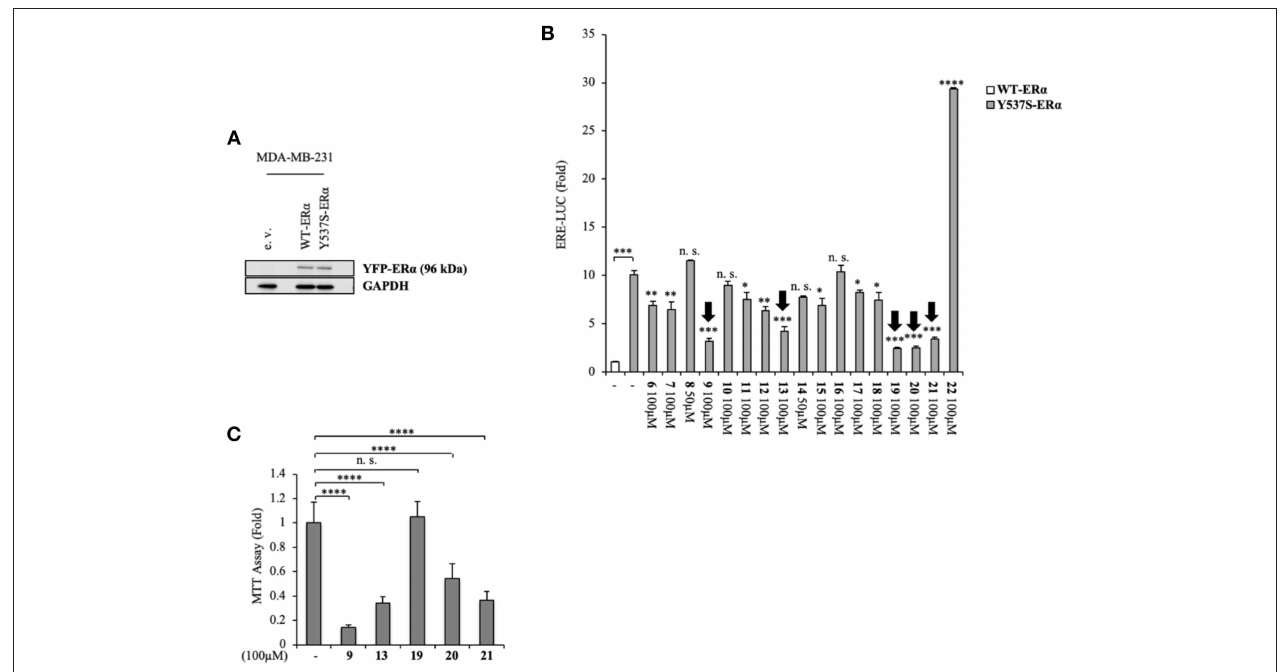
FIGURE 2 | Inhibition of Y537S ER α activation exerted by the compound 19 in MDA-MB-231 breast cancer cells. (A) Immunoblotting showing exogenous ER α protein expression in ER α -negative MDA-MB-231 breast cancer cells transiently transfected with an empty vector (e. v.), YFP-WT or YFP-Y537S ER α expression vectors. GAPDH was used as a control for equal loading and transfer. (B) ER α -transactivation assay in MDA-MB-231 cells transiently transfected with YFP-WT or YFP-Y537S ER α expressing vectors plus an ERE-luciferase reporter (XETL), and treated with vehicle (-) or the different compounds ( 6 - 22 ), as indicated. Data are reported as fold change relative to WT-ER α expressing cells. (C) MTT cell viability assay in MDA-MB-231 cells treated with vehicle (-) or the different compounds ( 9 , 13 , 19 , 20 , 21 , 100 µ M), as indicated for 24h. Results are expressed as fold change relative to vehicle-treated cells. The values represent the mean ± S. D. of three different experiments, each performed in triplicate. n. s., non-significant; * P < 0.05; ** P < 0.005; *** P < 0.0005; **** P < 0.00005.